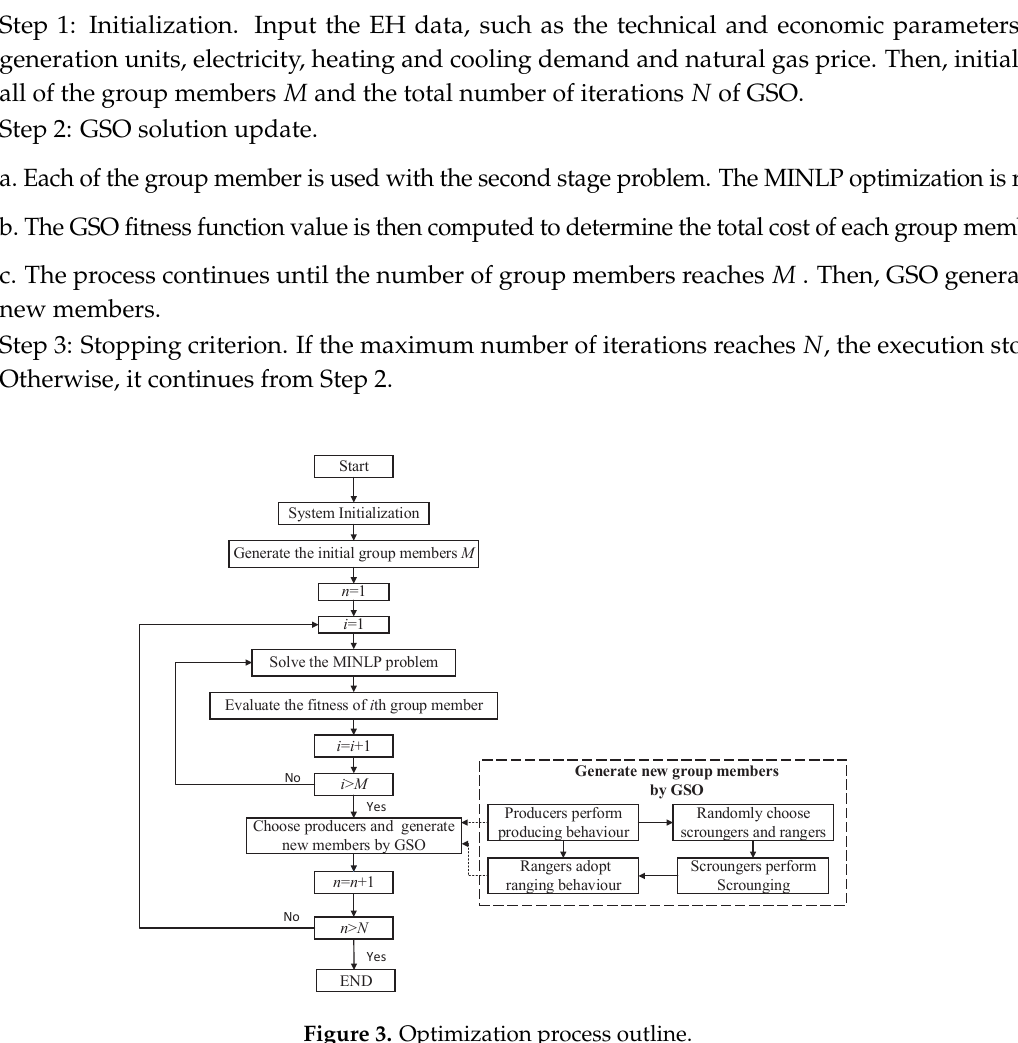
Figure 3. Optimization process